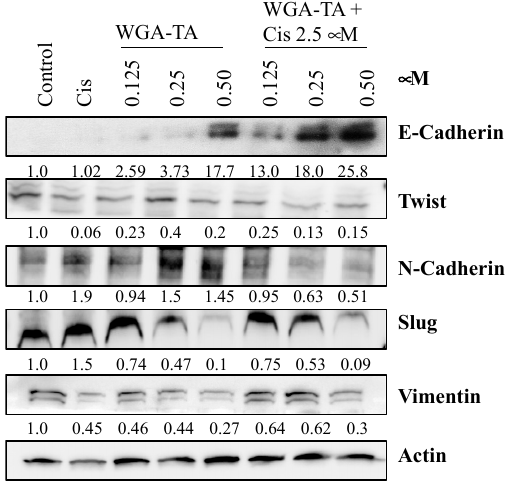
Figure 5. Immunoblot analysis of MDA-1986 cells treated with either 1.25 or 2.5 μ M cisplatin alone or in combination with 0.25 or 0.50 μ M WGA-TA for 24 h.